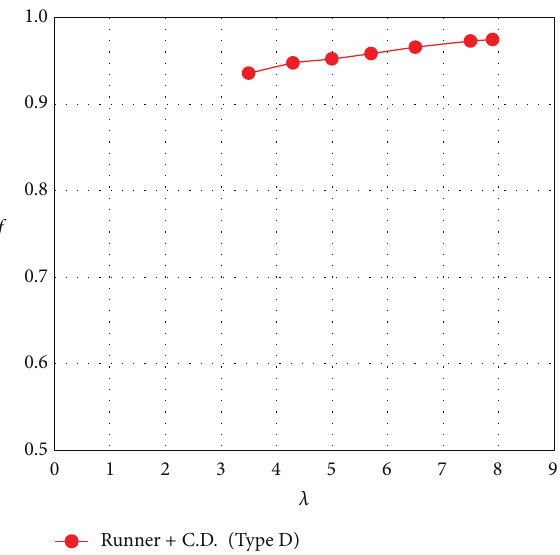
Figure 17: Correlation between the tip speed ratio and the correc- tion coefficient.